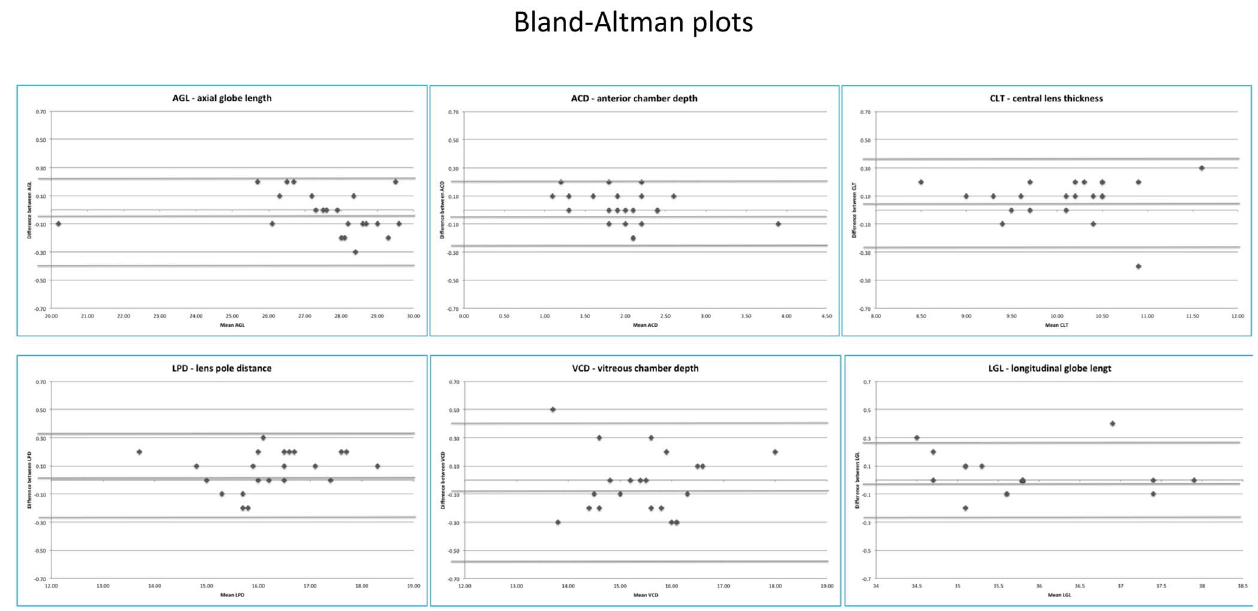
Figure 1. Bland-Altman plots. AGL=axial globe length; ACD=anterior chamber depth; CLT=central lens thickness; LPD=lens poles distance; VCD=vitreous chamber depth; LGL=longitudinal globe length.